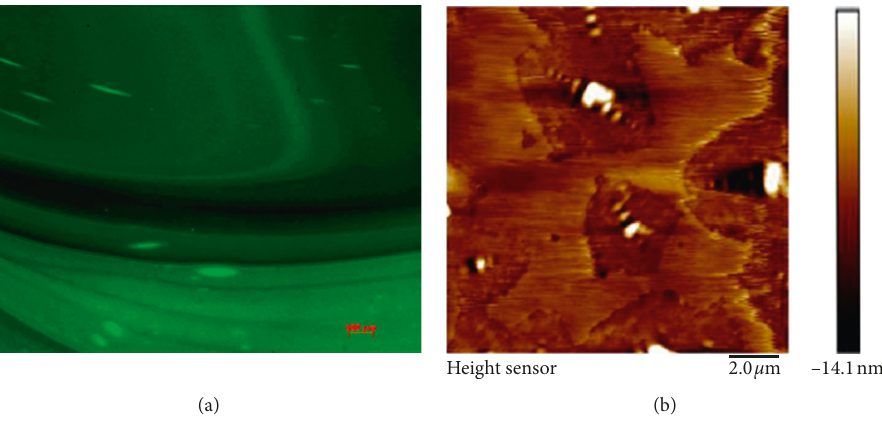
Figure 4: Asphalt sample view obtained from a fluorescence microscope on the left and an atomic force microscope on the right. The left figure is obtained from Kraus [17] (under the creative commons attribution license/public domain).